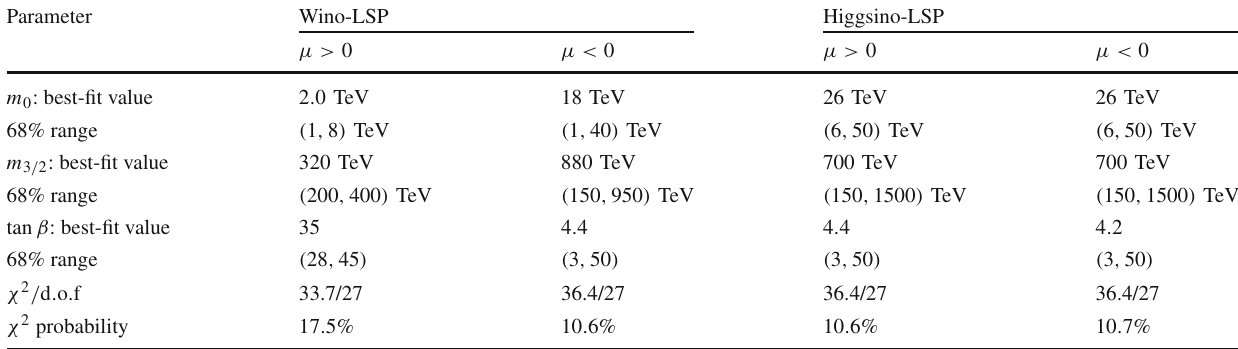
Fig. 13 The ( m 0 , m 3 / 2 ) planes ( upper panels ) and the ( tan β, m 3 / 2 ) planes ( lower panels ) for μ > 0 ( left panels ) and for μ < 0 ( right panels ), allowing the ˜ χ 0 to contribute only part of the CDM density. The shadings are the same as in Fig. 4 1 Table 5 Fit results for the mAMSB assuming that the LSP accounts for numbers of degrees of freedom (including the electroweak precision justafractionofthecolddarkmatterdensity.The68%CLrangescorre- observables) using the standard prescription [82]. Each mass range is spond to (cid:9)χ 2 = 1. We also display the values of the global χ 2 function shown for both the wino- and Higgsino-LSP scenarios and both signs of omitting the contributions from HiggsSignals , and the correspond- ing χ 2 probability values calculated taking into account the relevant